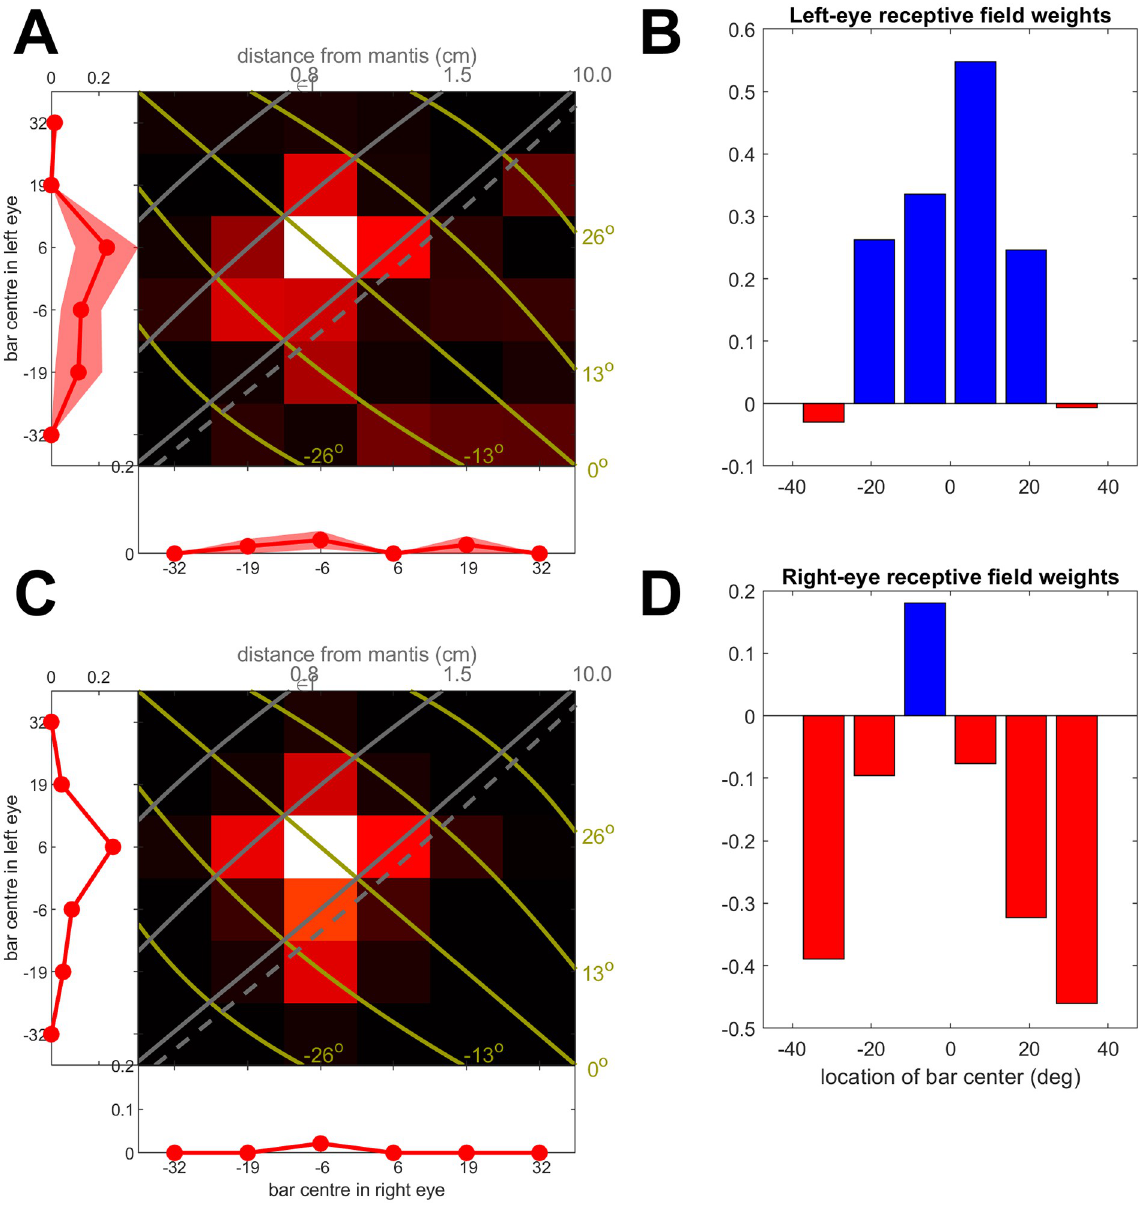
Fig 3. Response of real neuron (A, columnar commissural neuron rr160127 from [22]), along with response (C) predicted by the disparity energy model with the receptive field functions shown in B,D for left, right eyes. Here, due to experimental constraints on recording time, the stimuli were long vertical bars 13˚ in width, so the receptive fields are obtained only coarsely and as a function of only horizontal position. The receptive fields in both eyes have an excitatory centre (positive weights, blue) and inhibitory surround (negative, red). In the receptive fields fitted to this particular neuron, the excitatory centre is wider in the left eye than the right eye; elsewhere in this paper, we enforced symmetry for simplicity. The fitted threshold here is b = 0 and the output exponent is γ = 2.24; see Eqs (1) and (2). See [22] and its Supplementary Information for a detailed description of how responses are plotted in A and C for the real and model neuron respectively. Briefly, the marginal plots show the responses to monocular bars flashed in left or right eyes. The pseudocolor shows the responses to binocular bars, with the location in left, right eyes given by the location along vertical, horizontal axes. The olive lines mark the azimuthal location of the stimulus and the gray lines its disparity (dashed line indicates infinite simulated distance, or zero disparity). This neuron responded best to a bar flashed at a location corresponding to 2.5cm away on the